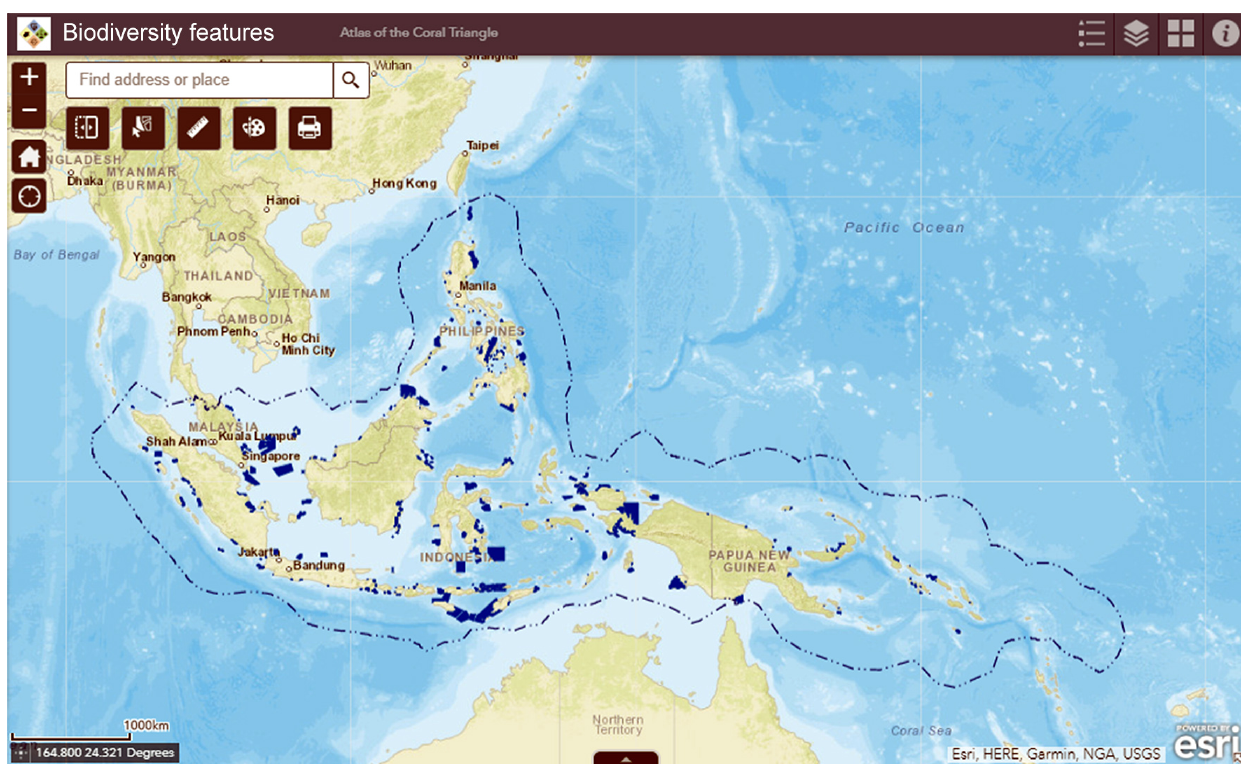
Figure 2. The interface of the Atlas of the Biodiversity Conservation of the Coral Triangle. The Coral Triangle countries’ EEZs (blue-dashed line) and distribution of marine protected areas (blue) are